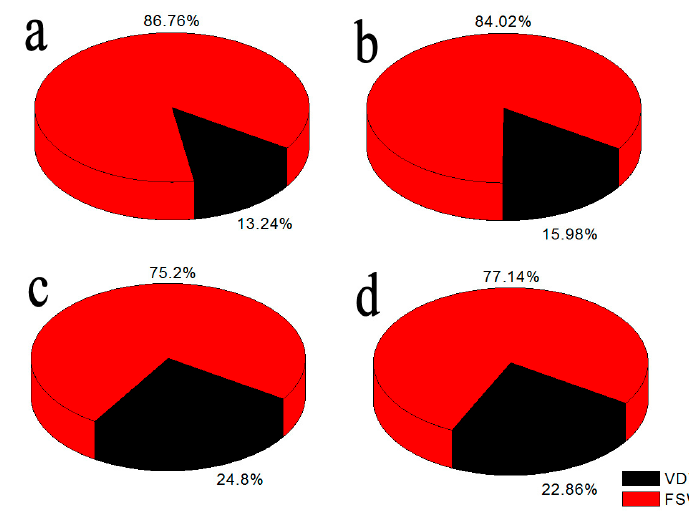
Figure 13. The proportion of joint shear force: ( a ) Mg99.50/non-zinc-coated DP600; ( b ) AZ31/non-zinc-coated DP600; ( c ) Mg99.50/DP600; and ( d ) AZ31/DP600.